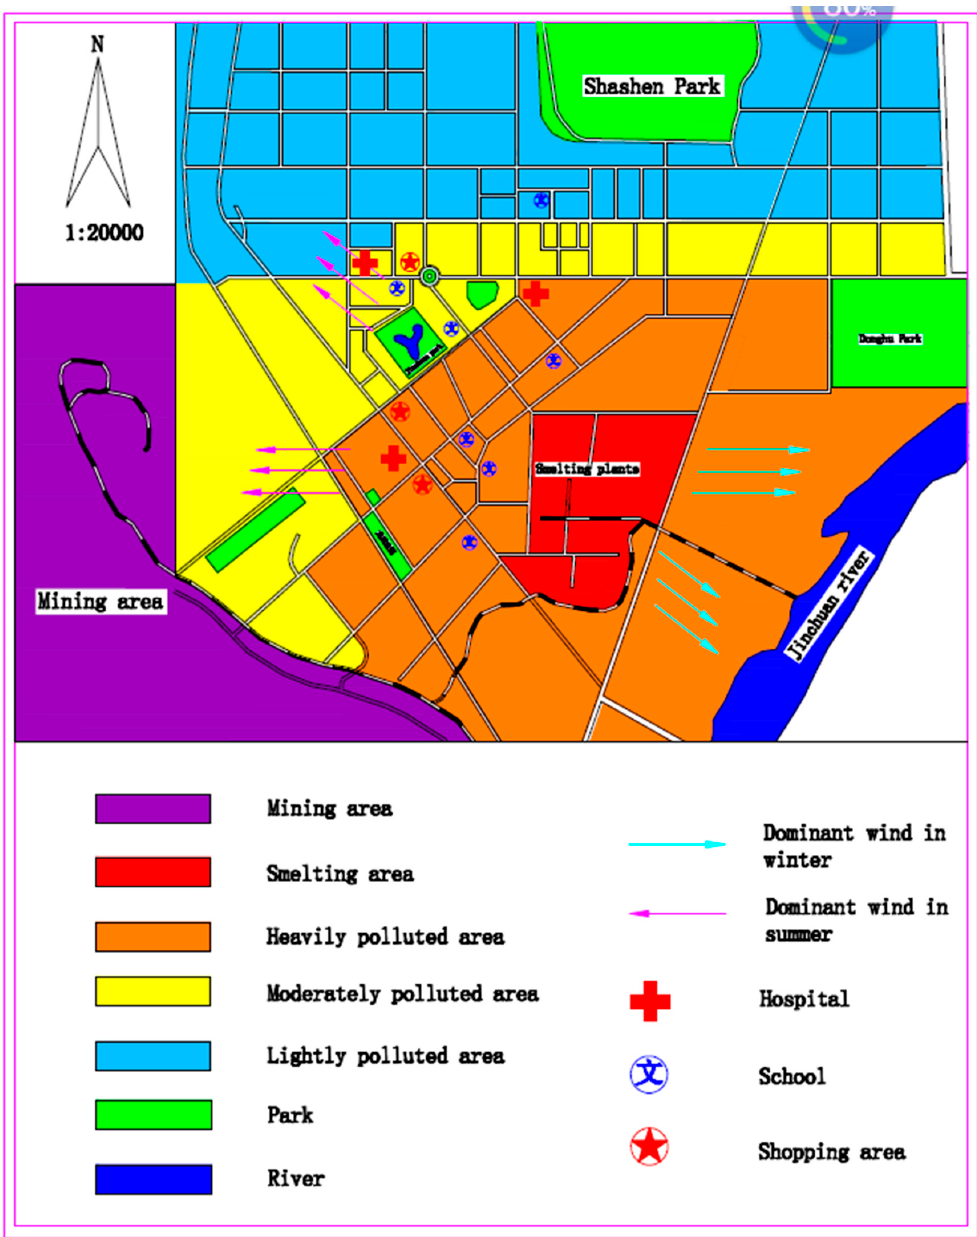
Figure 1. Heavily, moderately and lightly polluted areas of the Jinchuan mining area. Note: the dominant wind directions are from the east and south-east during summer and from west and north-west during winter. Source: JEQMR [40], Wei [4] and Li et al., [41].